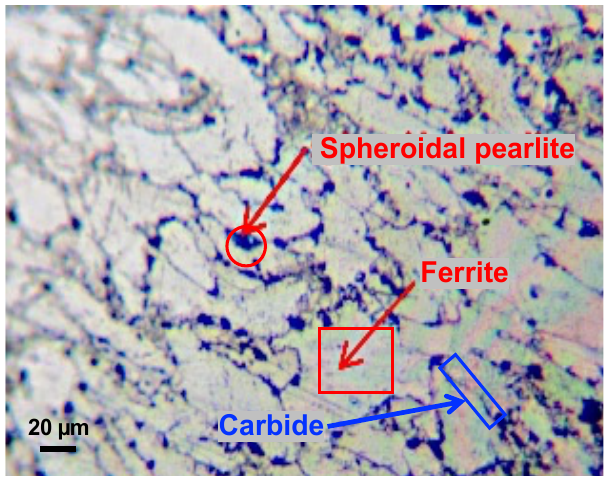
Figure 2. Metallographic organization of 12Cr1MoV steel running for 60,000 h.